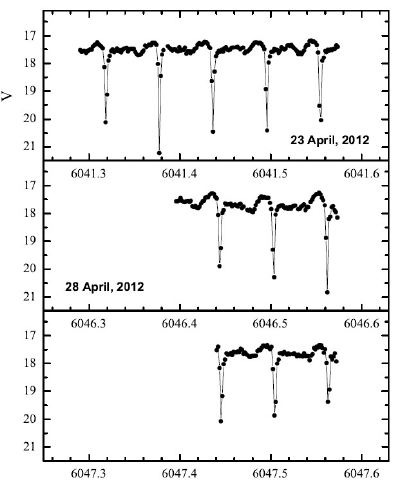
Figure 2: Light curves of high inclination system J1502 showing both superhumps and eclipses.